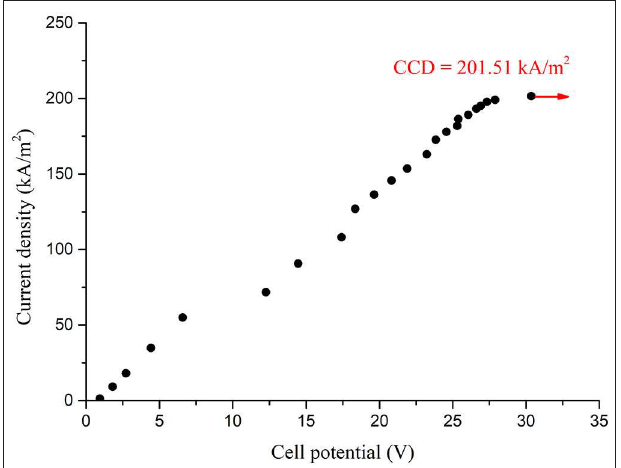
FIGURE 5 | Cell potential-current density curve.